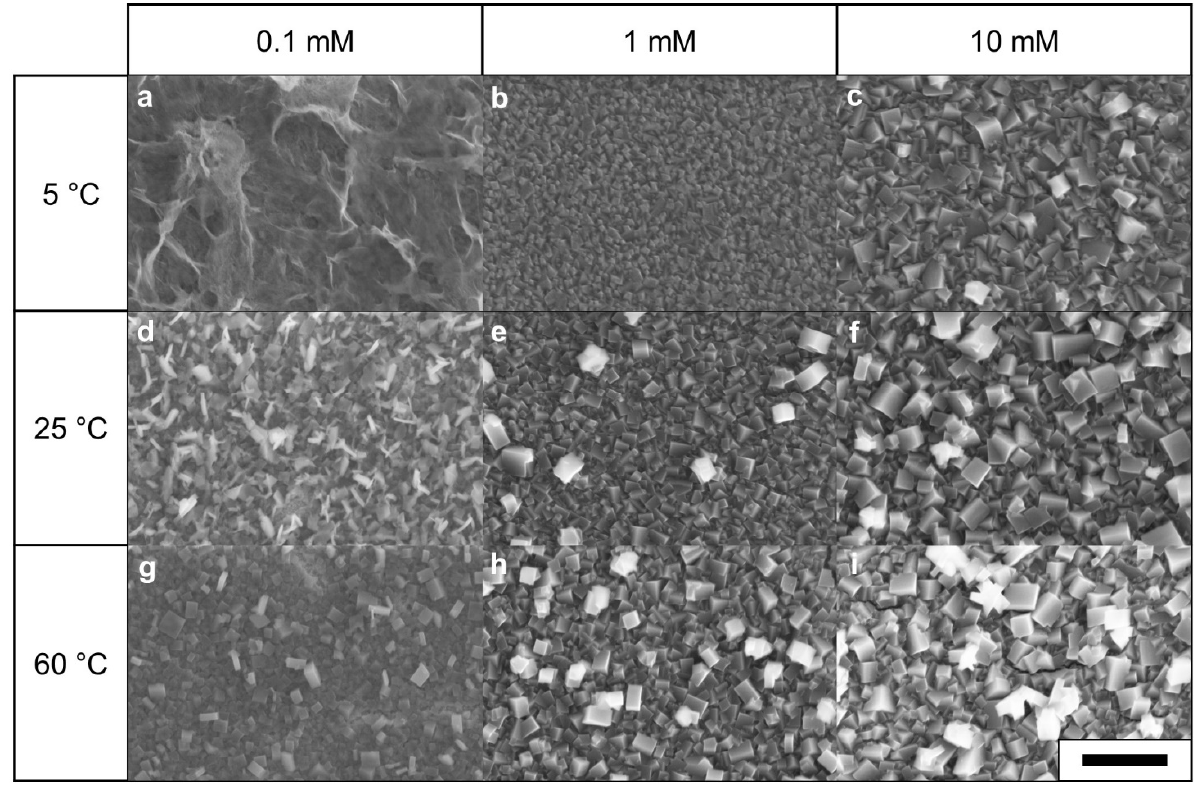
Figure 3. SEM images of CuHCFe thin films grown at various temperatures and concentrations of K 3 Fe(CN) 6 solution: ( a ) 0.1 mM & 5 °C, ( b ) 1 mM & 5 °C, ( c ) 10 mM & 5 °C, ( d ) 0.1 mM & 25 °C, ( e ) 1 mM & 25 °C, ( f ) 10 mM & 25 °C, ( g ) 0.1 mM & 60 °C, ( h ) 1 mM & 60 °C, and ( i ) 10 mM & 60 °C. Scale bar: 1 μ m.